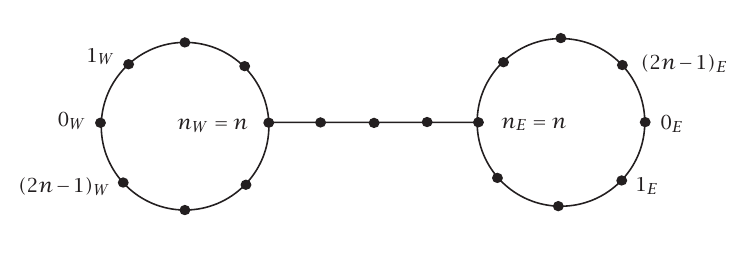
Figure 3.2 . The dumbbell Q in Theorem